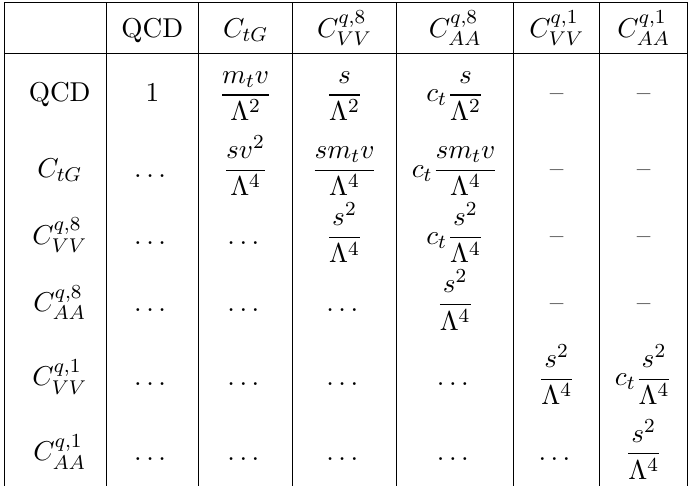
Table 2 . Relative scaling of operator contributions with respect to QCD in top pair production p ( q (cid:22) q ! t (cid:22) t ) at high energies s (cid:29) m t .